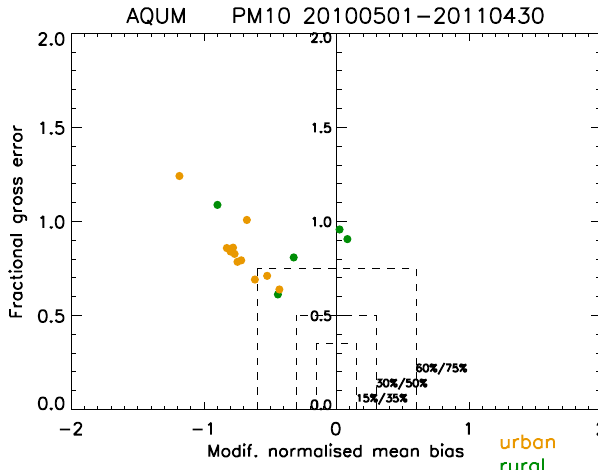
Fig. 3. Soccer plot for NO 2 for the period 1 May 2010 to 30 April 2011. Urban background and suburban sites are shown in orange, while remote and rural sites are given in green.